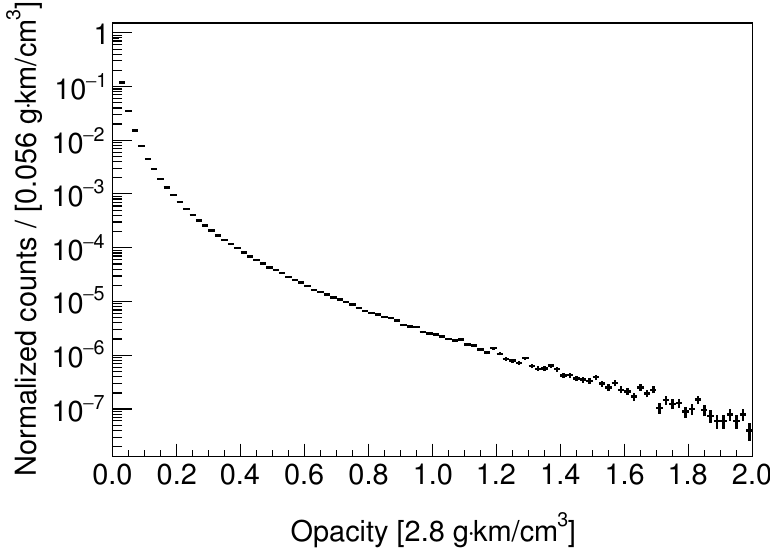
Figure 2. Distribution of opacity of the matter with which sea-level muons interact until stopping or